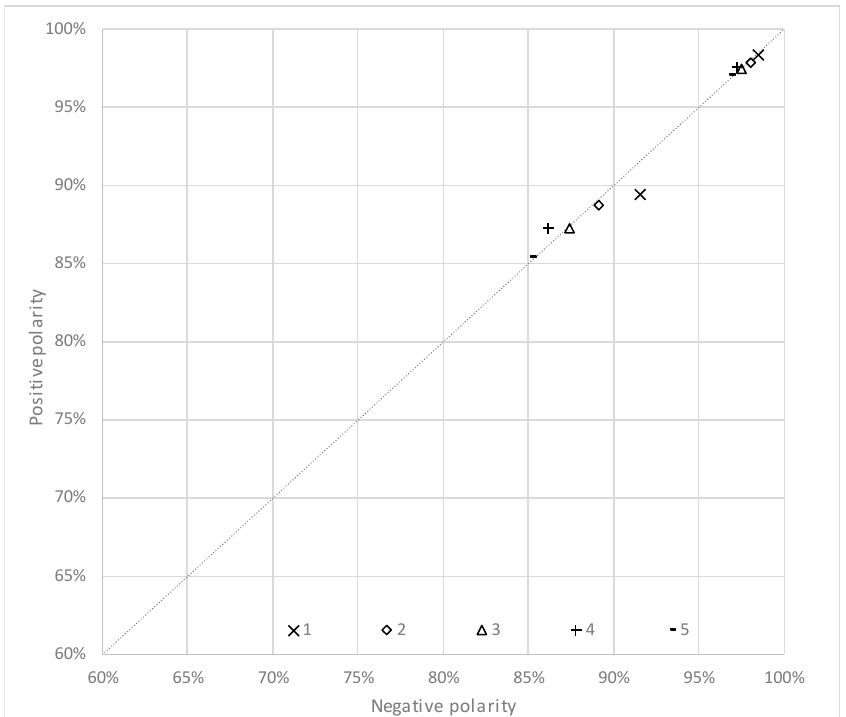
Figure 13. Product PSD after a different number of pulses (feed monosize 1000/500 µm) and different polarity.